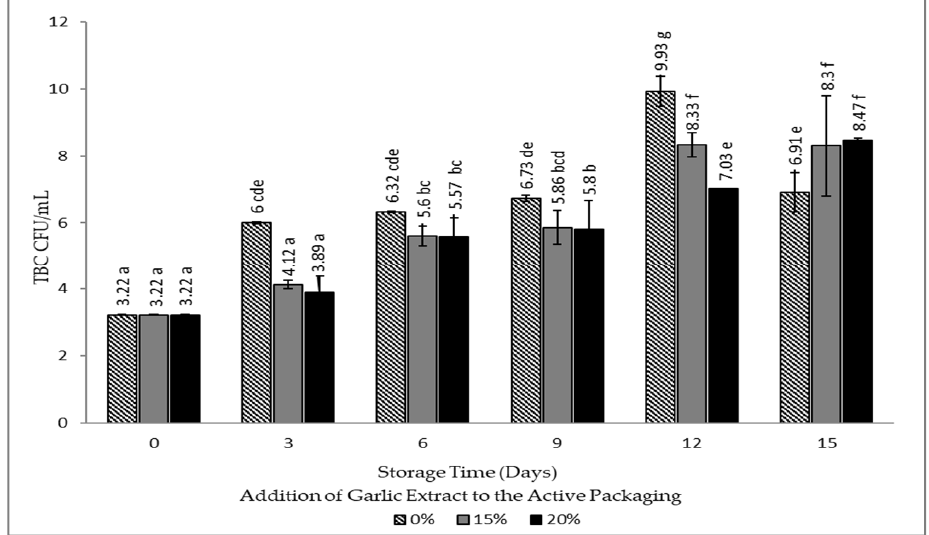
Figure 6. Graph for TBC value of beef packaged using intelligent and active packaging with the addition of garlic extract. The mean value followed by various letters indicates a significant difference ( p < 0.05).